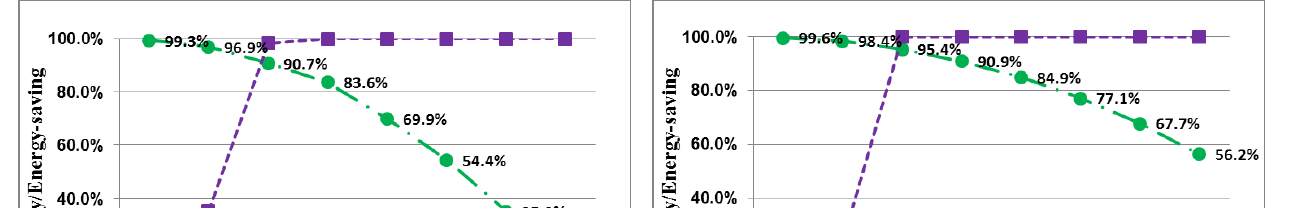
Figure 8. A comparison of the simulation results for energy savings and reachability with different node densities. ( a ) density = 0.0005 nodes/m 2 ; ( b ) density = 0.001 nodes/m 2 ; ( c ) density = 0.005 nodes/m 2 ; ( d ) density = 0.01 nodes/m 2